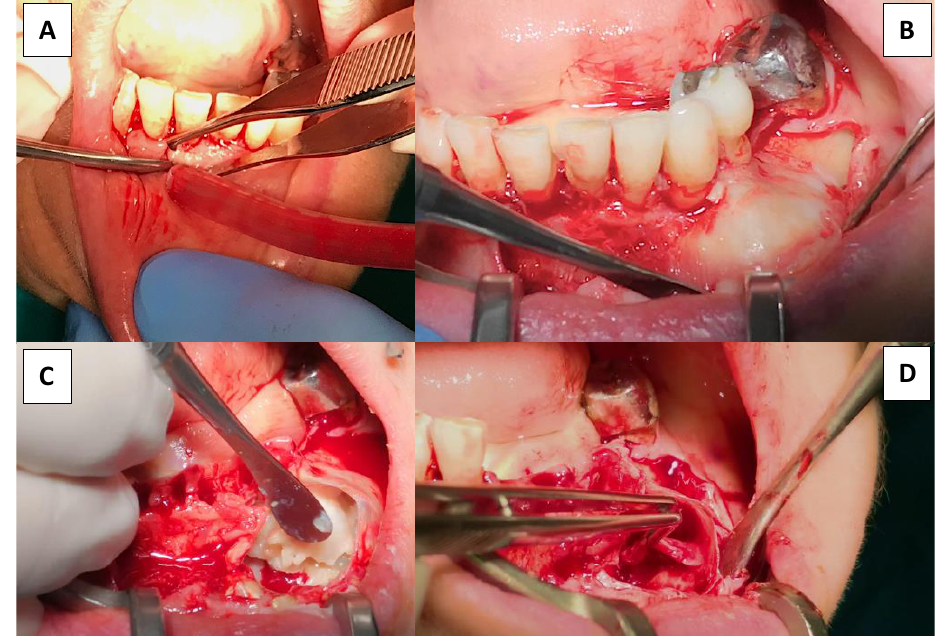
Figure 6. ( A ) Vestibular sulcular and releasing incision to access lesion. ( B ) Cortical bone expansion visualization following flap raise. ( C ) Cystic content before surgical emptying resembling cheesy appearance. ( D ) Mental nerve isolation during cystic detachment from its surrounding bony adhesions.